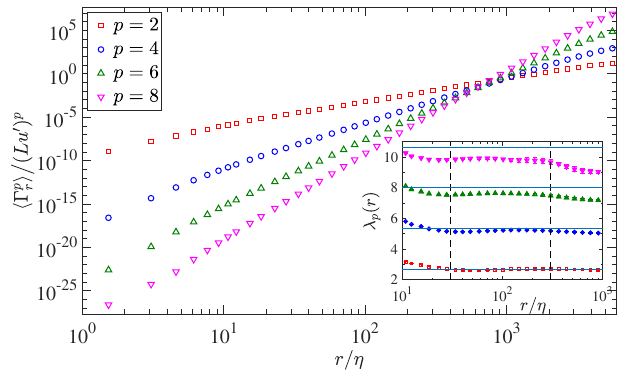
FIG. 6. Normalized circulation moments for various orders p as a function of the linear dimension of the loop, for R λ ¼ 1300 . Inset shows corresponding local slopes λ p ¼ d ½ log h Γ p r i(cid:3) =d ½ log r (cid:3) , with vertical lines demarcating the inertial range. Error bars (which are often subsumed by the symbol thickness) indicate 95% confidence intervals. Horizontal straight lines drawn at 4 p= 3 correspond to K41